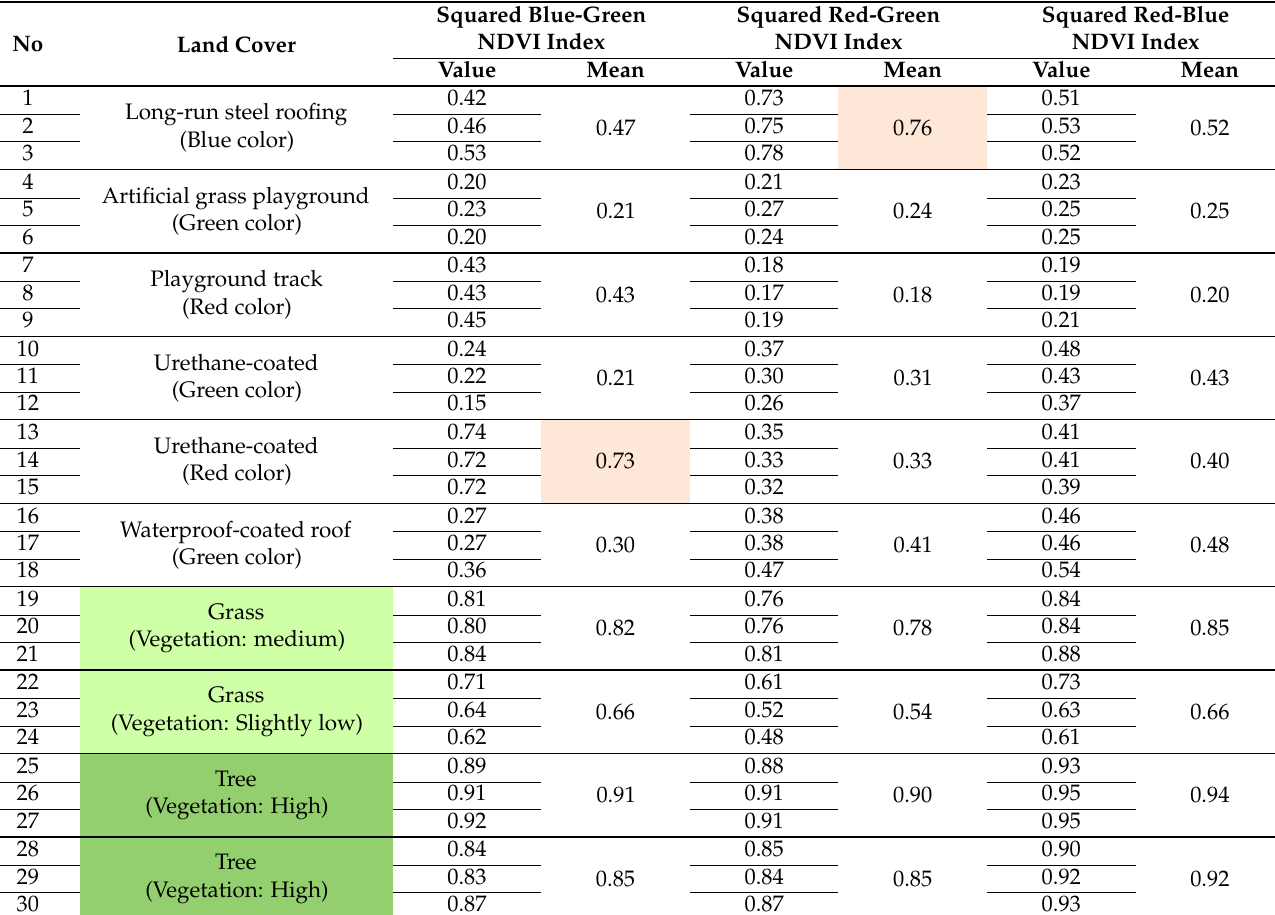
Table 7. Comparison of vegetation index values by type of land cover using the novel